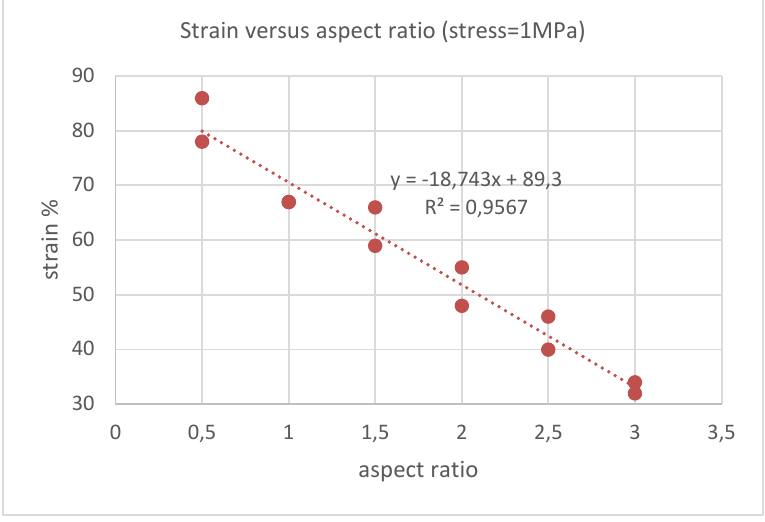
Fig. 3: Strain (%) versus Aspect ratio for the different H-pieces and derived polynomial